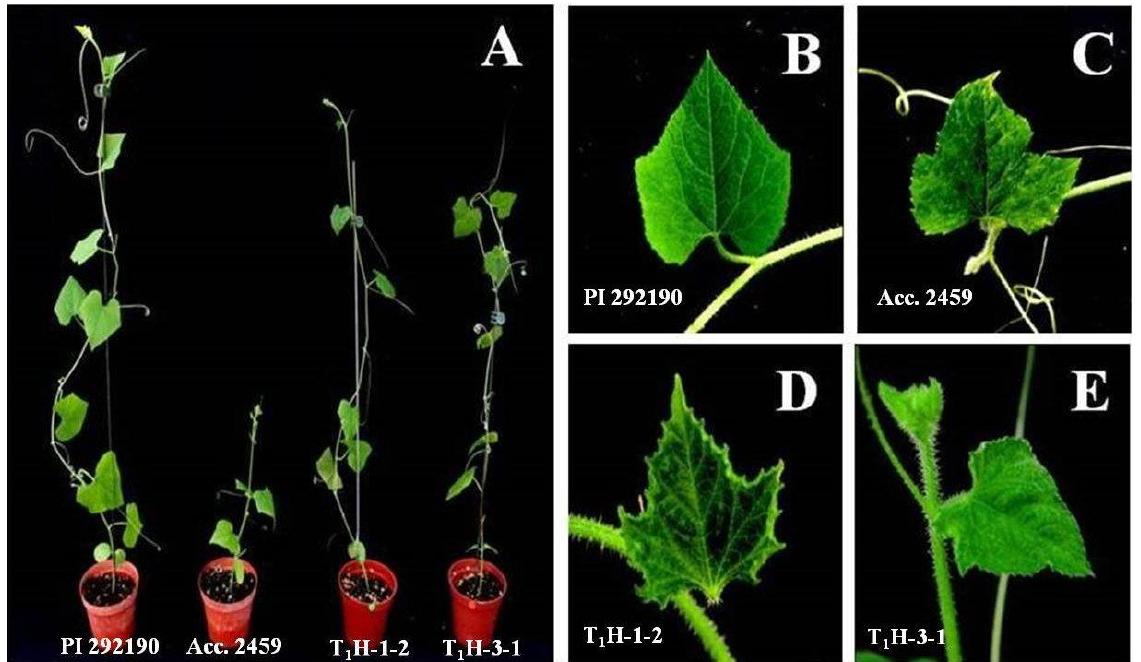
Figure 5. Effect of CmSPI gene silencing on PRSV inoculated C. metuliferus plants. ( A ) PRSV symptoms on the whole plant are shown for C. metuliferus reistance line PI 292190, susceptible line Acc. 2459, CmSPI RNAi transgenic line T H-1-2, and CmSPI RNAi transgenic line T H-3-1 (from left to right); PRSV symptoms on leaves for ( B ) PI 292190; ( C ) Acc. 2459; ( D ) transgenic line T H-1-2; and ( E ) transgenic line T H-3-1.